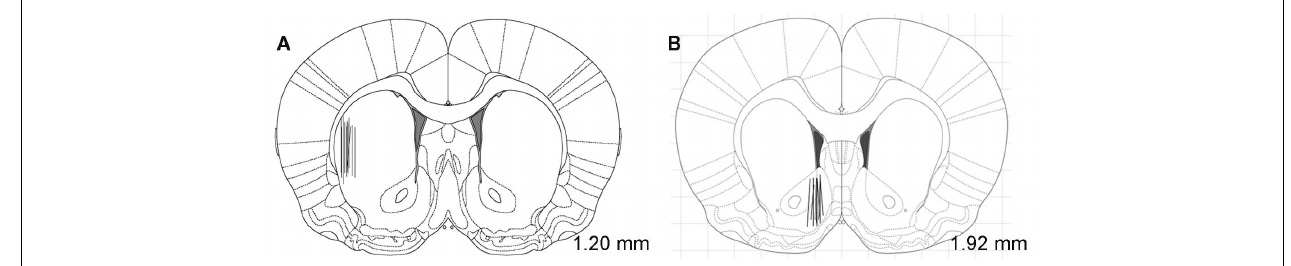
FIGURE 5 | Location of the microdialysis probes in the DLS and nAc. The black lines indicate the track of individual microdialysis probes in the DLS (A) and the nAc (B) . Distance from bregma (in mm) is shown to the right in each figure.